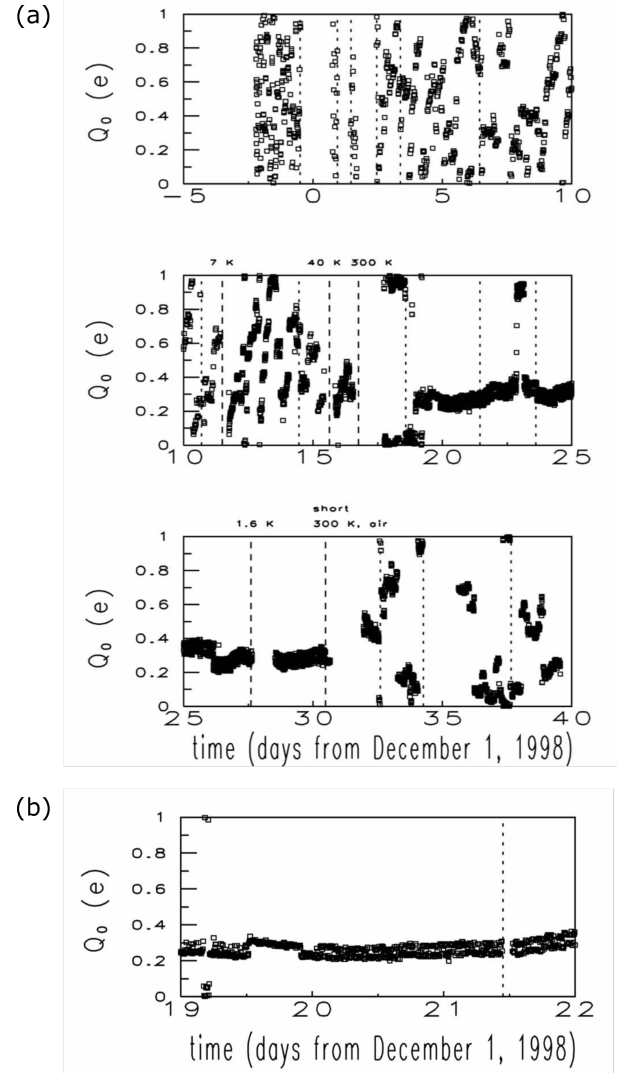
Figure 3. ( a ) typical charge offset drift of metal (Al/AlO x /Al) devices. A large amount of drift is observed. Unlabeled vertical dashed lines correspond to either liquid helium transfers or accidental losses of data; ( b ) a zoomed in set of the data in ( a ) between days 19 and 22 showing the two distinct values of charge offset drifts in the device at this time. The data were recorded at 20 mK unless indicated in the figure with fine print above dashed lines. Reproduced with permission from reference [30], Copyright 2008, American Institute of